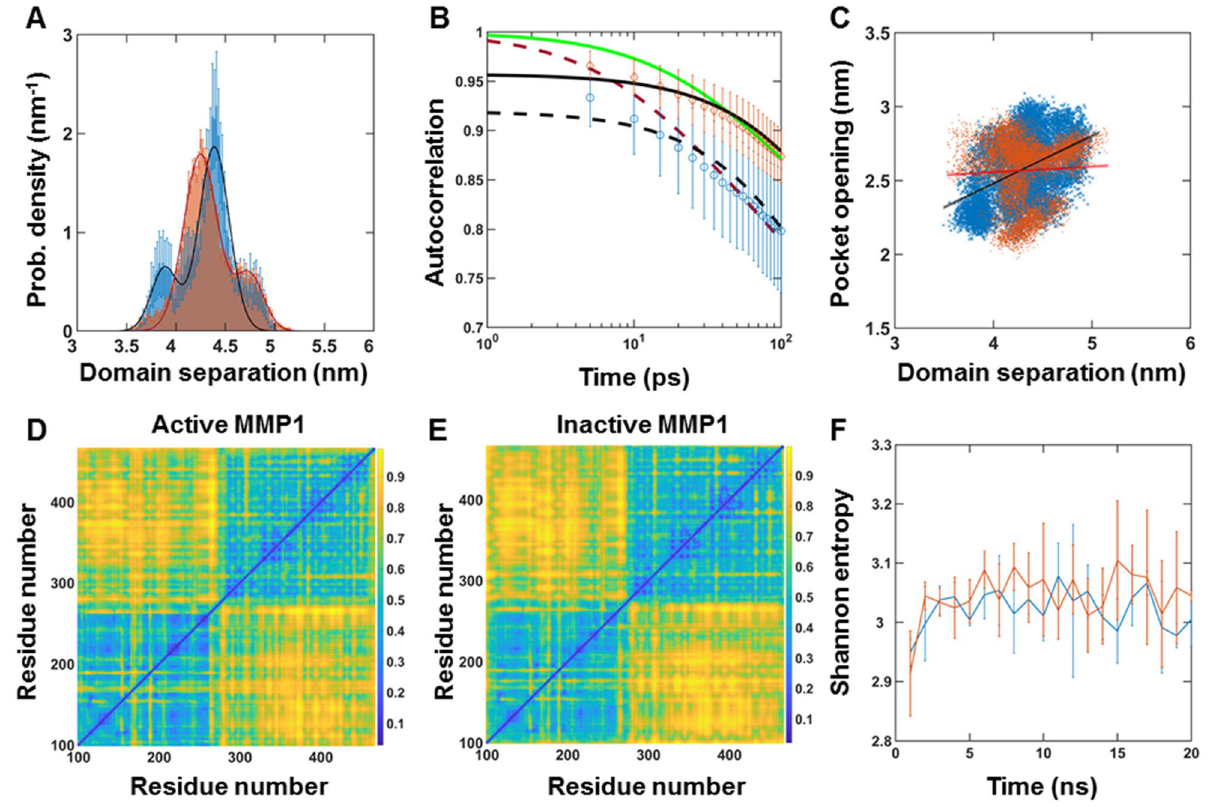
Figure 5. All-atom MD simulation of MMP1 interdomain dynamics of pose 3 at 22 °C. ( A ) Area-normalized histograms of simulated interdomain distance (active: blue; inactive: orange) with best fits to a sum of two Gaussians (solid line). ( B ) Autocorrelations of simulated interdomain distance (active: blue; inactive: orange) with fits to exponentials (active: dashed black line; inactive: solid black line). Power law does not fit autocorrelations (active: dashed red line; inactive: solid green line). ( C ) Linear correlation plots of catalytic pocket opening and interdomain distance. The plot shows combined data from the three repeats of simulations for pose 3. ( D,E ) Mean correlations between residues of three repeats of simulations for pose 3 for active and inactive MMP1, respectively. Correlations are normalized between 0 (blue) and 1 (yellow). Yellowish colors indicate higher correlations. ( F ) Shannon entropy calculated from correlation plots for active (S = 3.02 ± 0.03, mean ± SEM) and inactive (S = 3.04 ± 0.04, mean ± SEM). For best-fit parameters, see Table S4. The error bars in ( A , B , F ) represent the standard deviations of three repeats of simulations for pose 3. ( C ) shows combined data from the three